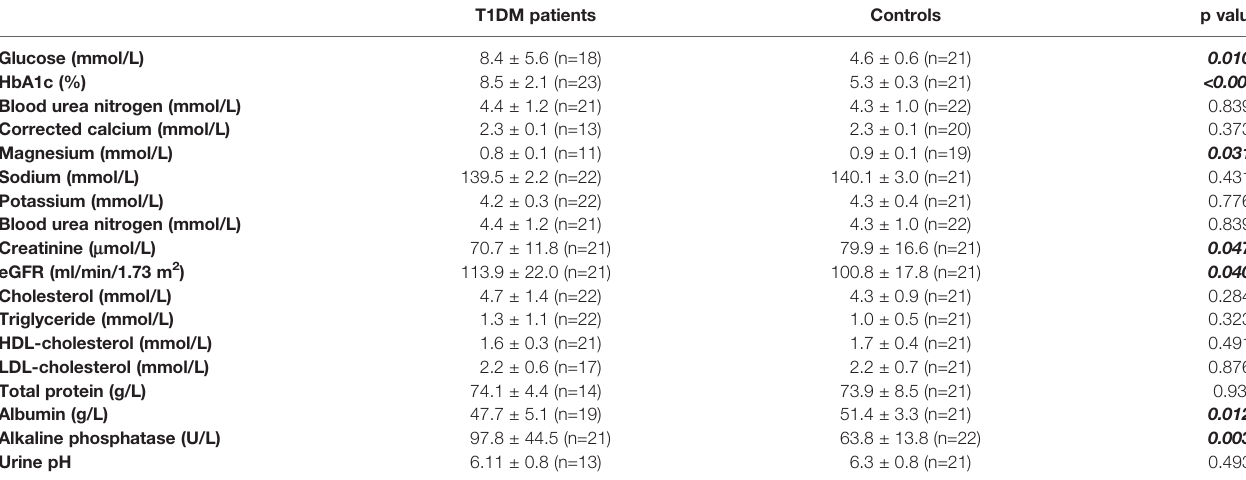
TABLE 2 | Laboratory data in the study